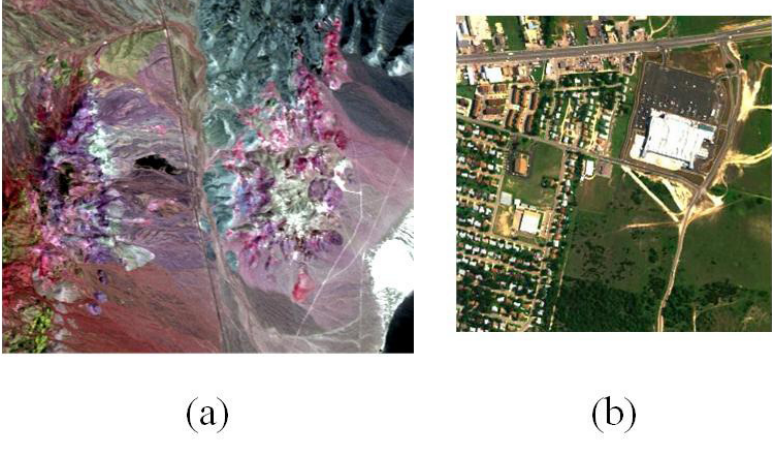
Figure 4. ( a ) False color composition of the Cuprite dataset. ( b ) True color composition of the Urban